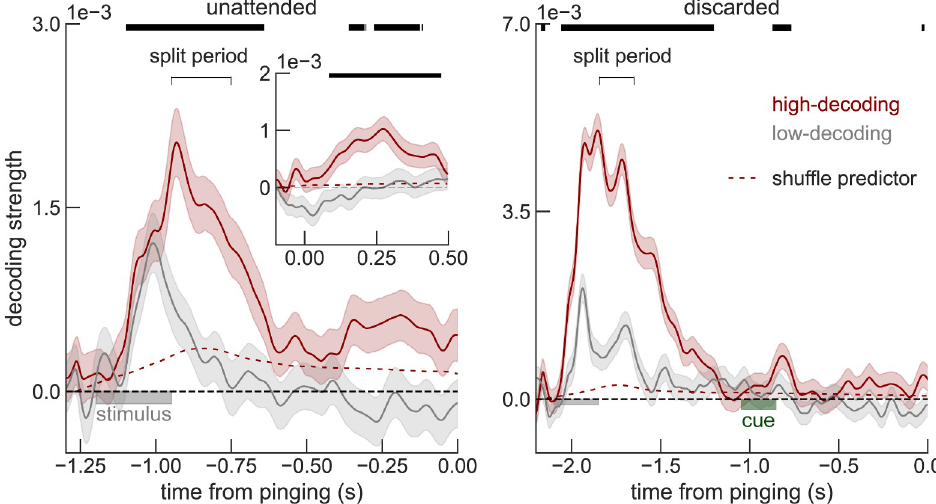
Fig 3. Sessions with high early-delay (split period, Methods) voltage decoding have a sustained code for unattended memories (left, red), but not for discarded memories (right). Replotting the reactivation period (inset), separately for high and low early-delay decoding sessions shows that “reactivations” only occur for sessions with a sustained code (left, red). Note that at time 0, the decoding strength is not actually zero (inset vs arrow). This is an artifact of baselining during the delay period (see also S3 Fig). Error bars are sem. Decoding strengths from high-decoding sessions were compared to the shuffle predictor (top black bars mark significant deviation, one-sided p < 0.05, Methods). Time course and data are similar to Fig 1A and 1B. Data from Wolff and colleagues (2017)